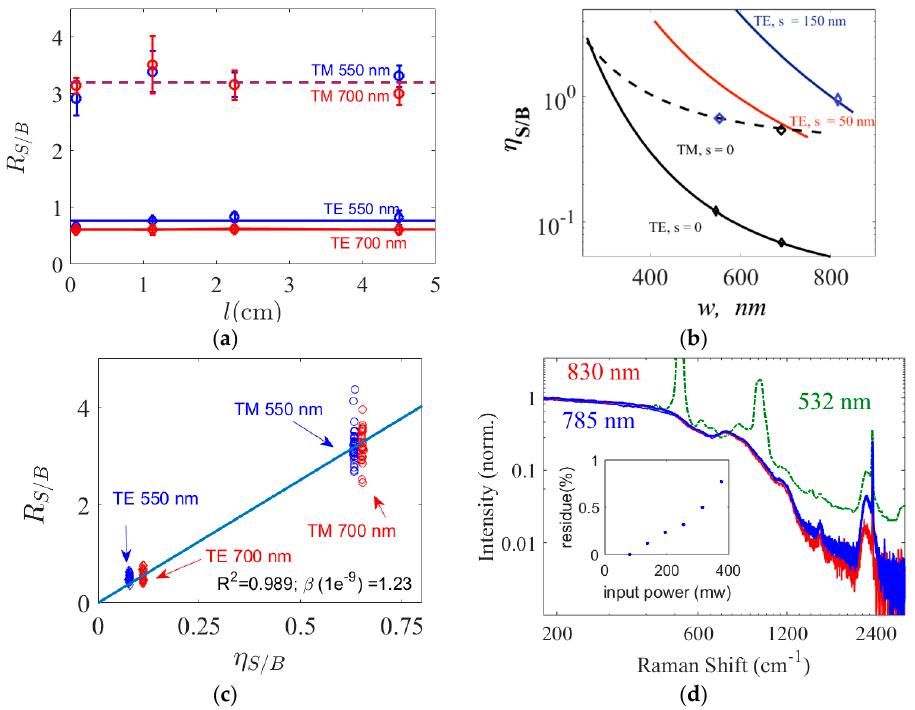
Figure 4. ( a ) The ratio of signal to the WGBL counts ( R S/B ) as a function of length evaluated at 819 cm − 1 corresponding to an isopropyl alcohol (IPA) peak. We observe that R S/B remains practically a constant. The blue lines are for a 550 nm wide waveguide and the red lines are for a 700 nm wide waveguide, while dashed lines are evaluated for the M polarization and solid lines for the TE polarization; ( b ) Calculated ratio of signal to the WGBL conversion efficiencies, η S/B , as a function of waveguide width for SiN waveguides with h = 220. Diamond markers correspond to the widths investigated experimentally in Figure 3a; ( c ) Average ratio of signal to the WGBL counts ( R A/B ) plotted against the calculated η S/B . The R 2 of the fit is 0.989 and yields β BG = 1.2 ± 0.1 × 10 − 9 sr − 1 ·cm − 1 at the Raman 819 cm − 1 ; ( d ) The WGBL measured by exciting the waveguide at 532 nm (green dashed), 785 nm (blue), and 830 nm (red) wavelengths. The green dashed spectra are adapted from [18] and measured with a z-scan, hence they contain extra peaks at 520 and 960 cm − 1 due to silicon. The blue spectrums contain an overlap of several spectra measured with pump powers ranging from 60 to 380 mW. The inset shows the residue, Res i , of the spectral difference observed relative to the spectra obtained using 60 mW.